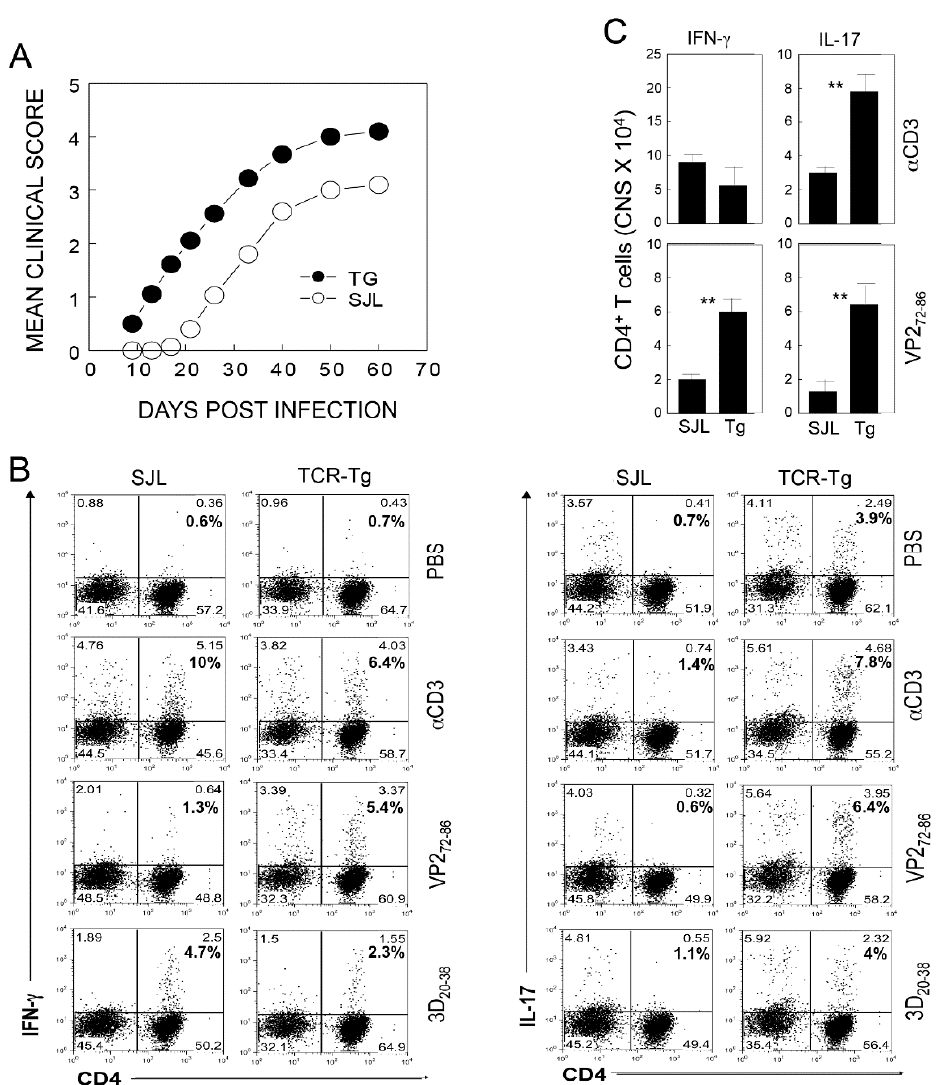
Figure 1. Effect of primed vs. naive CD4 + T cells specific for a viral determinant on the development of TMEV-induced demyelinating disease. ( A ) Control SJL and VP2-TCR-Tg mice were infected with TMEV (2 × 10 6 pfu / mouse), and the development of clinical symptoms was compared between the groups over 60 days. The two-tailed p values between the groups were significant based on a paired t test of the mean clinical cores between days 9 and 60 postinfection: p < 0.0001 ( t = 9.739 with 8 degrees of freedom) between the VP2-TCR-Tg group and the control SJL group. ( B ) Proportions of IFN- γ producing CD4 + T cells in the SJL and VP2-TCR-Tg mice. After 8 days of infection, CNS infiltrating cells were restimulated with PBS, anti-CD3 / CD28, 2 µ M VP2 72-86, or 3D 20-38 peptides for 6 h. The proportions of CD4 + T cells producing IFN- γ and IL-17 were determined using flow cytometry. ( C ) The numbers of CD4 + T cells producing IFN- γ and IL-17 in the CNS of TMEV-infected SJL and TCR-Tg mice at 8 dpi. ** p <